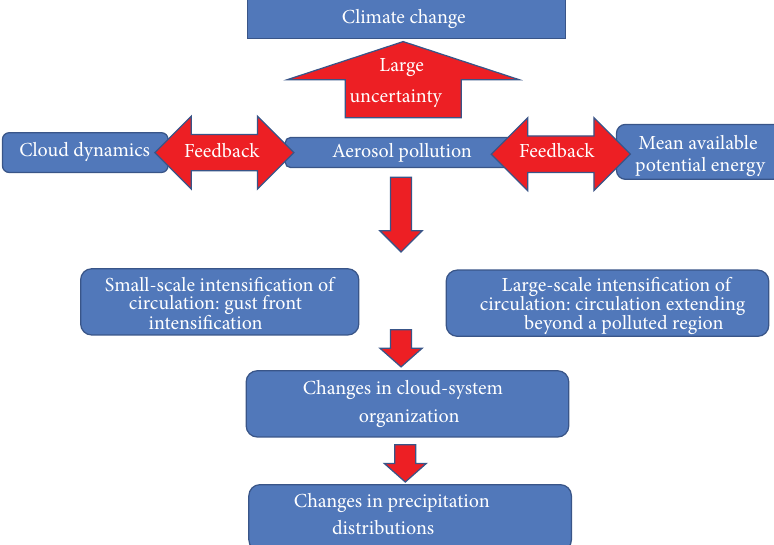
Figure 1: Schematic diagram illustrating the flow of this paper.